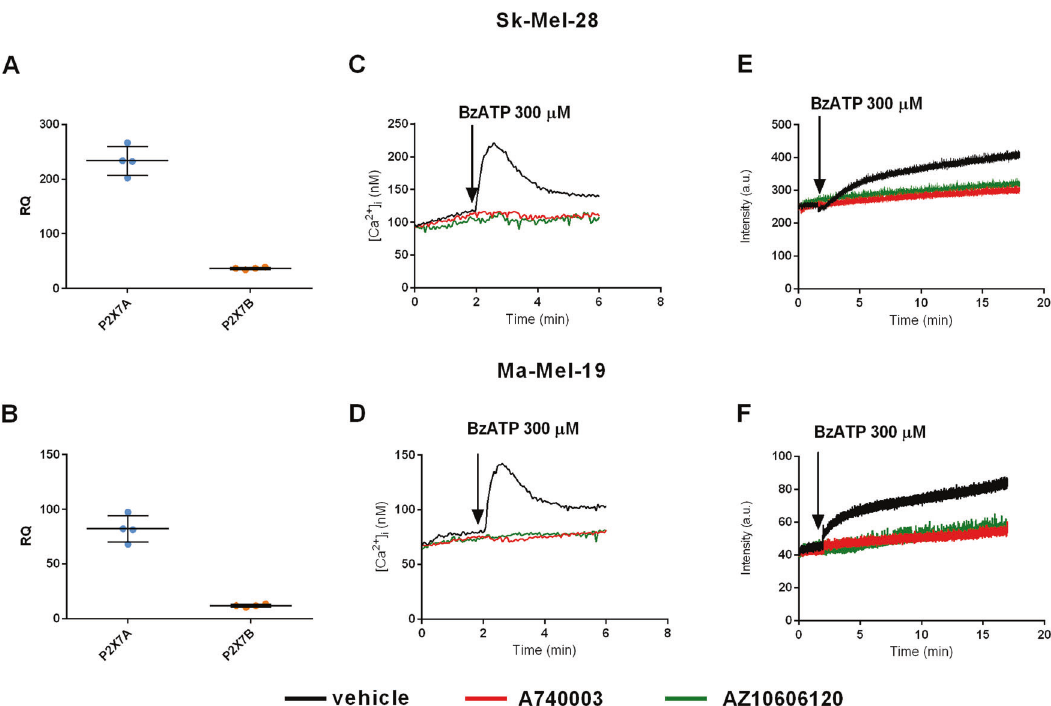
Fig. 2 Sk-Mel-28 and Ma-Mel-19 human melanoma cell lines express a functional P2X7 receptor. A mRNA expression of P2X7A and P2X7B in Sk-Mel-28 cells evaluated by real time-PCR ( N = 4). B mRNA expression of P2X7A and P2X7B in Ma-Mel-19 cells evaluated by real-time PCR ( N = 4). P2X7 receptor activity as a channel was evaluated in C Sk-Mel-28 cells and D Ma-Mel-19 cells by measuring variations in [Ca 2 + ] I following stimulation with P2X7R agonist BzATP (300 μ M). The P2X7 receptor antagonists A740003 (20 μ M) and AZ10606120 (2 μ M) completely obliterated the effect of BzATP. P2X7 activity as a large solute (up to 900 Da) pore was evaluated in E Sk-Mel-28 cells and F Ma-Mel-19 cells by measuring ethidium uptake following stimulation with BzATP (300 μ M). The P2X7 receptor antagonists A740003 (20 μ M) and AZ10606120 (2 μ M) blocked the effect of